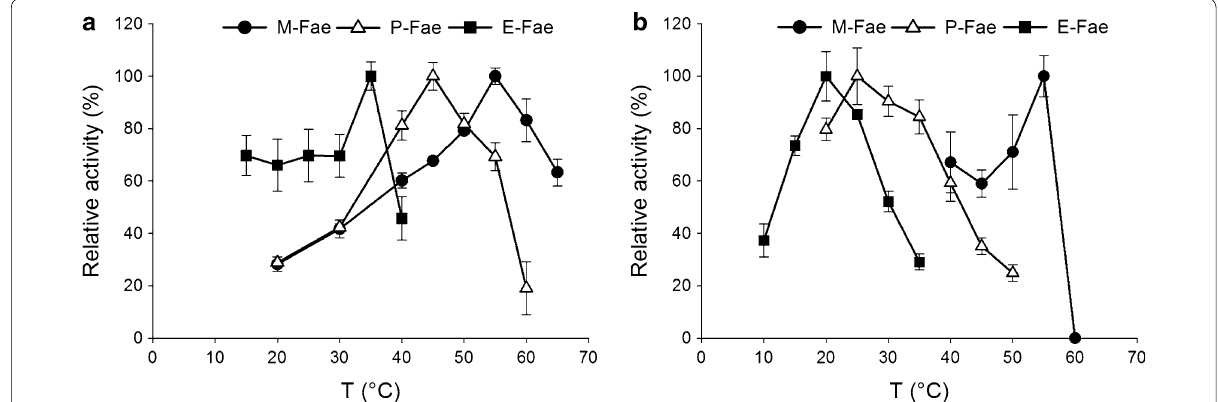
Fig. 4 Activity of the three Mt Fae1a versions in solution ( a ), and immobilized ( b ), as a function of temperature. Activities determined on M p CA, in sodium phosphate buffer at pH 7.0. Results given are averages of three experiments, and error bars represent one standard deviation